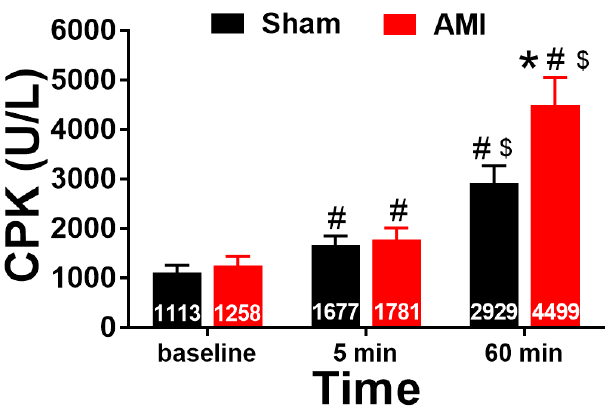
Figure 7. Total creatine phosphokinase (CPK) levels before coronary occlusion (baseline) and after 5 and 60 min of artery reperfusion in the AMI group (n = 9) and at the equivalent times in the sham group (n = 7). * p < 0.05 compared with sham, # p < 0.05 compared with preocclusion (baseline), and $ p < 0.05 compared with 5 min of reperfusion. Error bars = standard error of mean.